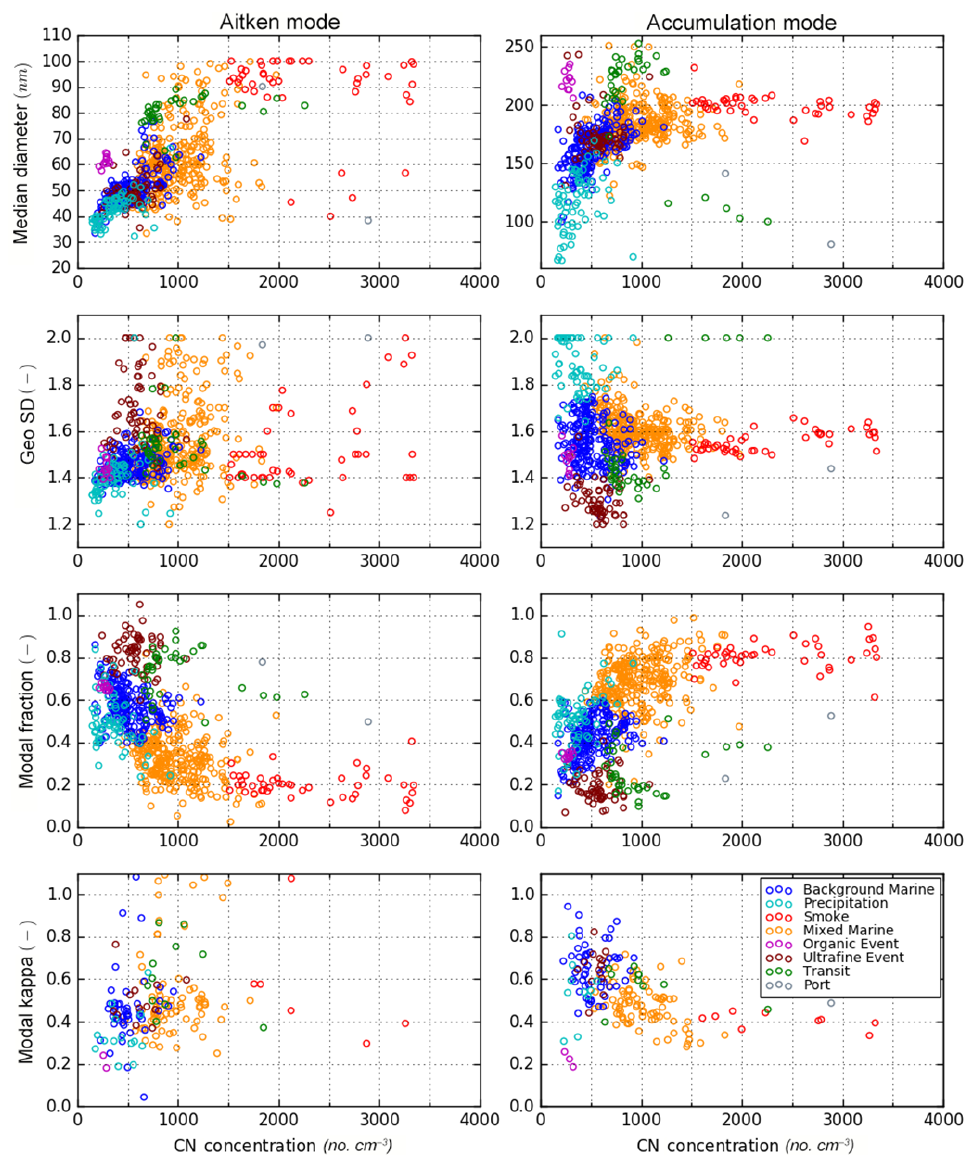
Figure 3. Parameterized variable values for Aitken and accumulation modes (median diameter, geometric standard deviation, modal fraction) at each of the 15min data points during the study, along with κ values for data points at CCNc supersaturation set points of 0.38% (Aitken mode) and 0.14% (accumulation mode). Each data point is colored according to the cluster type to which it was